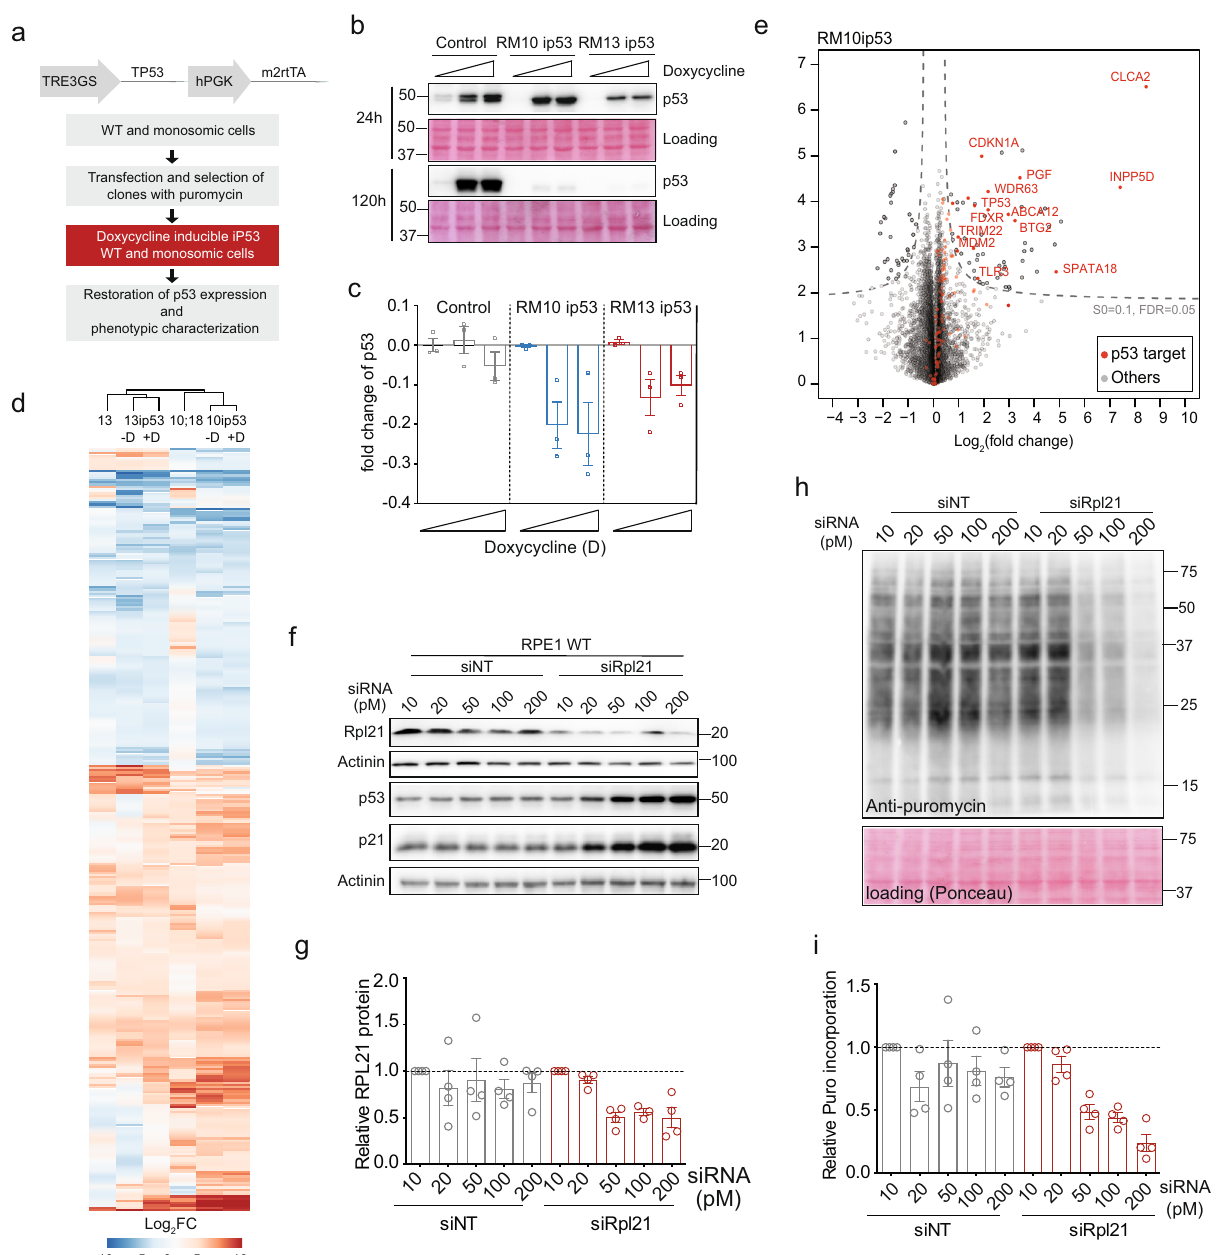
Fig. 6 Loss of p53 is essential for proliferation of monosomies. a Schematics depicting the construction of monosomic cell lines with doxycycline inducible p53 expression. b Immunoblotting of p53 after induction with doxycycline for 24 and 120 h. Ponceau staining was used as a loading control. c Quanti fi cation of the p53 intensities from b . The plots display the mean differential expression of p53 at 24 and 120 h of doxycycline treatment. All values were normalized to the respective loading control. D denotes doxycycline. Bars display the mean ± SEM of three independent experiments. d Heat map depicts the differentially regulated mRNA expression in monosomies compared to diploids, Hierarchical clustering of Euclidean distance. Gene expression fold changes greater than 2 or less than − 2 are used for heat map. e Volcano plot showing the transcripts of p53 targets upregulated in RM10 ip53 cell line with doxycycline treatment compared to no doxycycline (log 2 FC). Red dots represent known p53 targets. f siRNA mediated titrated knockdown of RPL21 in RPE1 induces p53 expression in a concentration-dependent manner. siNT was used as control. RPE1 p53 KO WT and RM 13 were used as a non- transfection control. The western blots are representative of three independent experiments. g Quanti fi cation of relative RPL21 levels from immunoblotting. All values were normalized to respective 10 pm samples. Actinin served as a loading control. Bars display the mean ± SEM of three independent experiments. h siRNA mediated knockdown of RPL21 reduces translation rate in RPE1 cells. The protein lysates from siNT and siRPL21 puromycin-labeled samples were immunoblotted with an anti-puromycin antibody. Ponceau staining was used as a loading control. The western blots are representative of three independent experiments. i Quanti fi cation of relative puromycin incorporation from immunoblotting. All values were normalized to respective 10 pm samples. Ponceau served as a loading control. Bars display the mean ± SEM of three independent experiments. Source data are provided in a Source Data fi